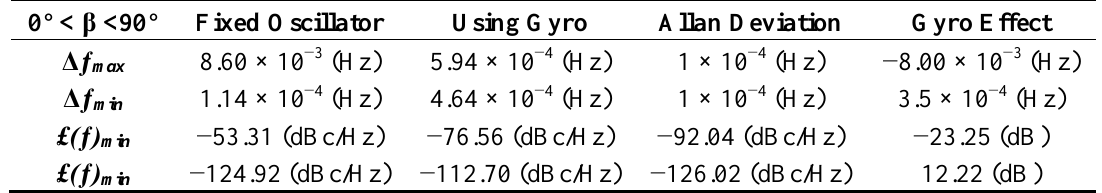
Figure 19. Comparison between sinusoidal vibrations-induced phase noise and Allan deviation safety margin. ( a ) Fixed oscillator; ( b ) Gyroscopic mounting. Table 6. Analysis of gyroscopic mounting efficiency for crystal with |φ| = 2.6°.